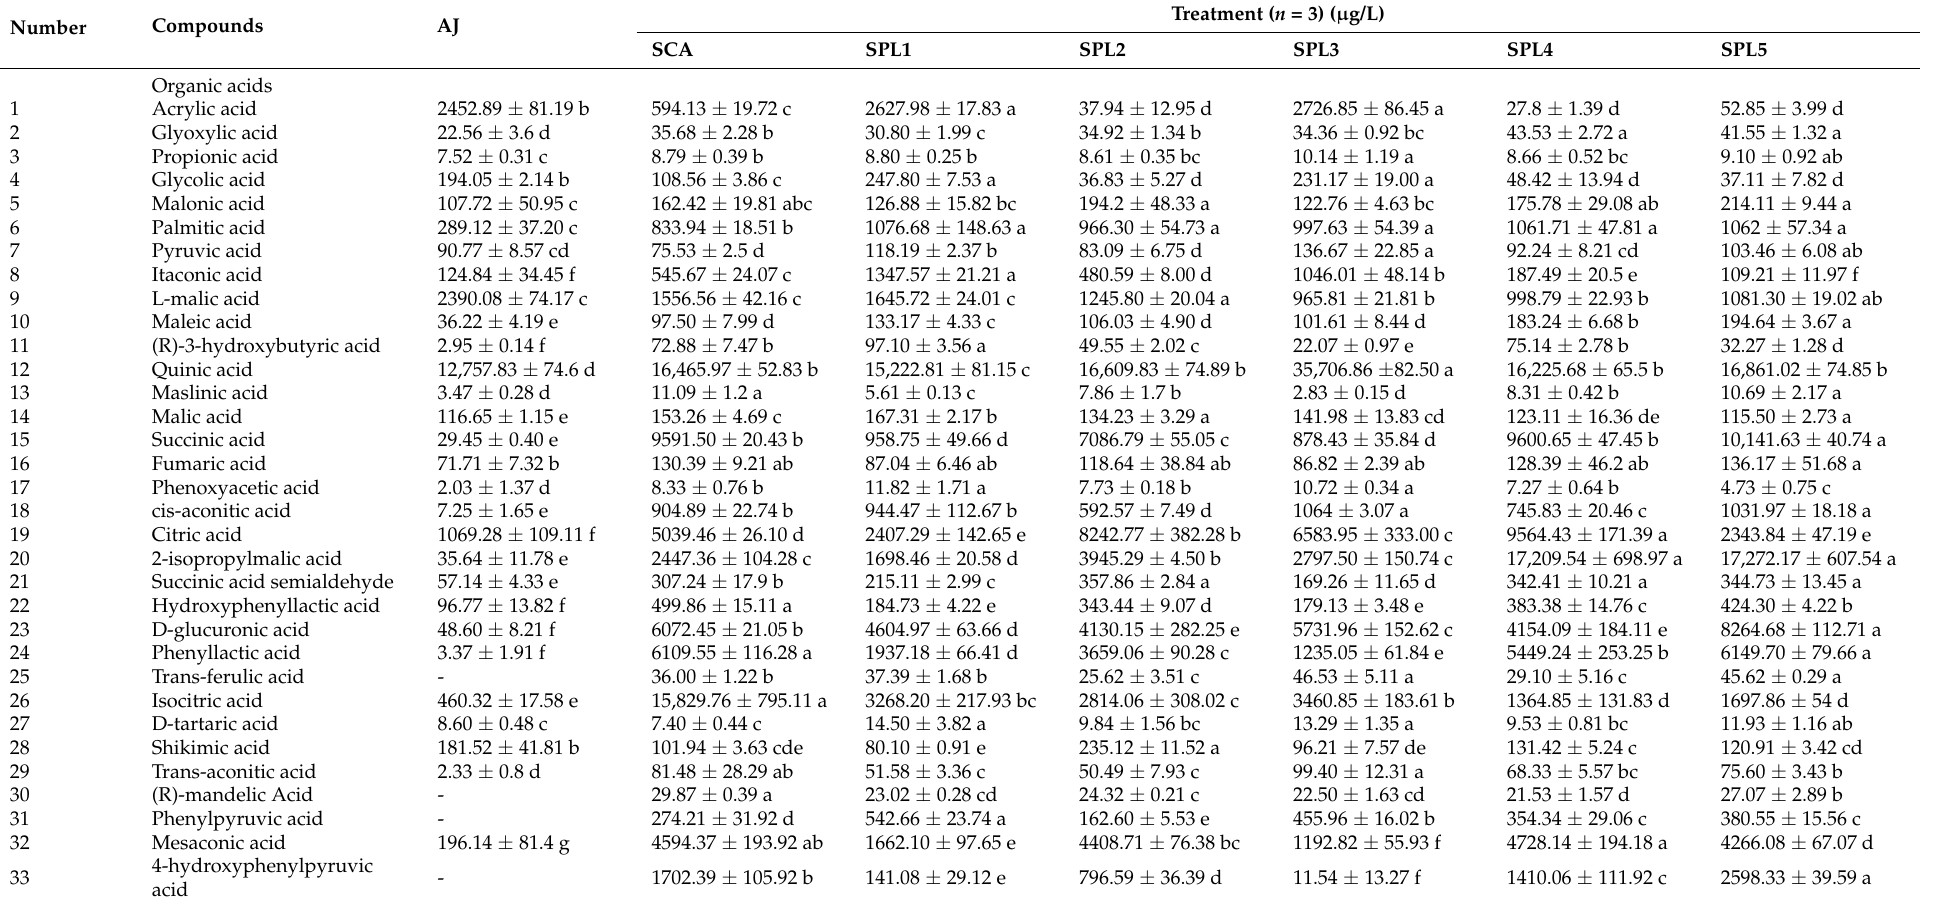
Table 3. Compounds determined by LC-MS/MS in apple juice and ciders fermented using single-culture and triple